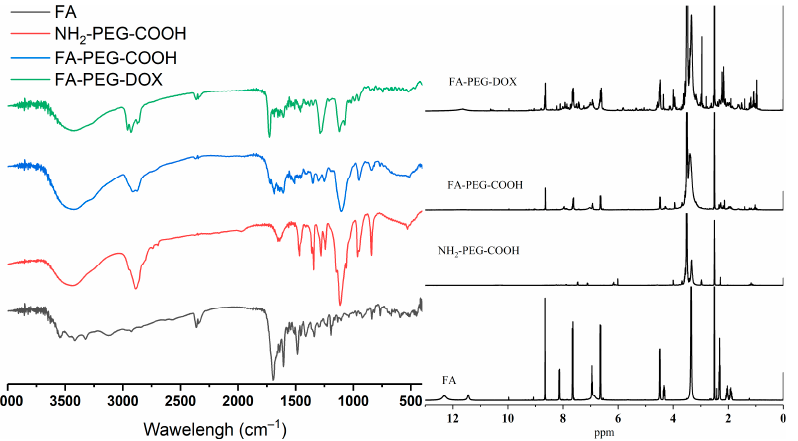
Figure 3. Synthesis of nanomaterials. FTIR of FA, NH 2 -PEG-COOH, FA-PEG-COOH, and FA-PEG- DOX ( left ) and 1 H NMR of FA, NH 2 -PEG-COOH, FA-PEG-COOH, and FA-PEG-DOX ( right ).